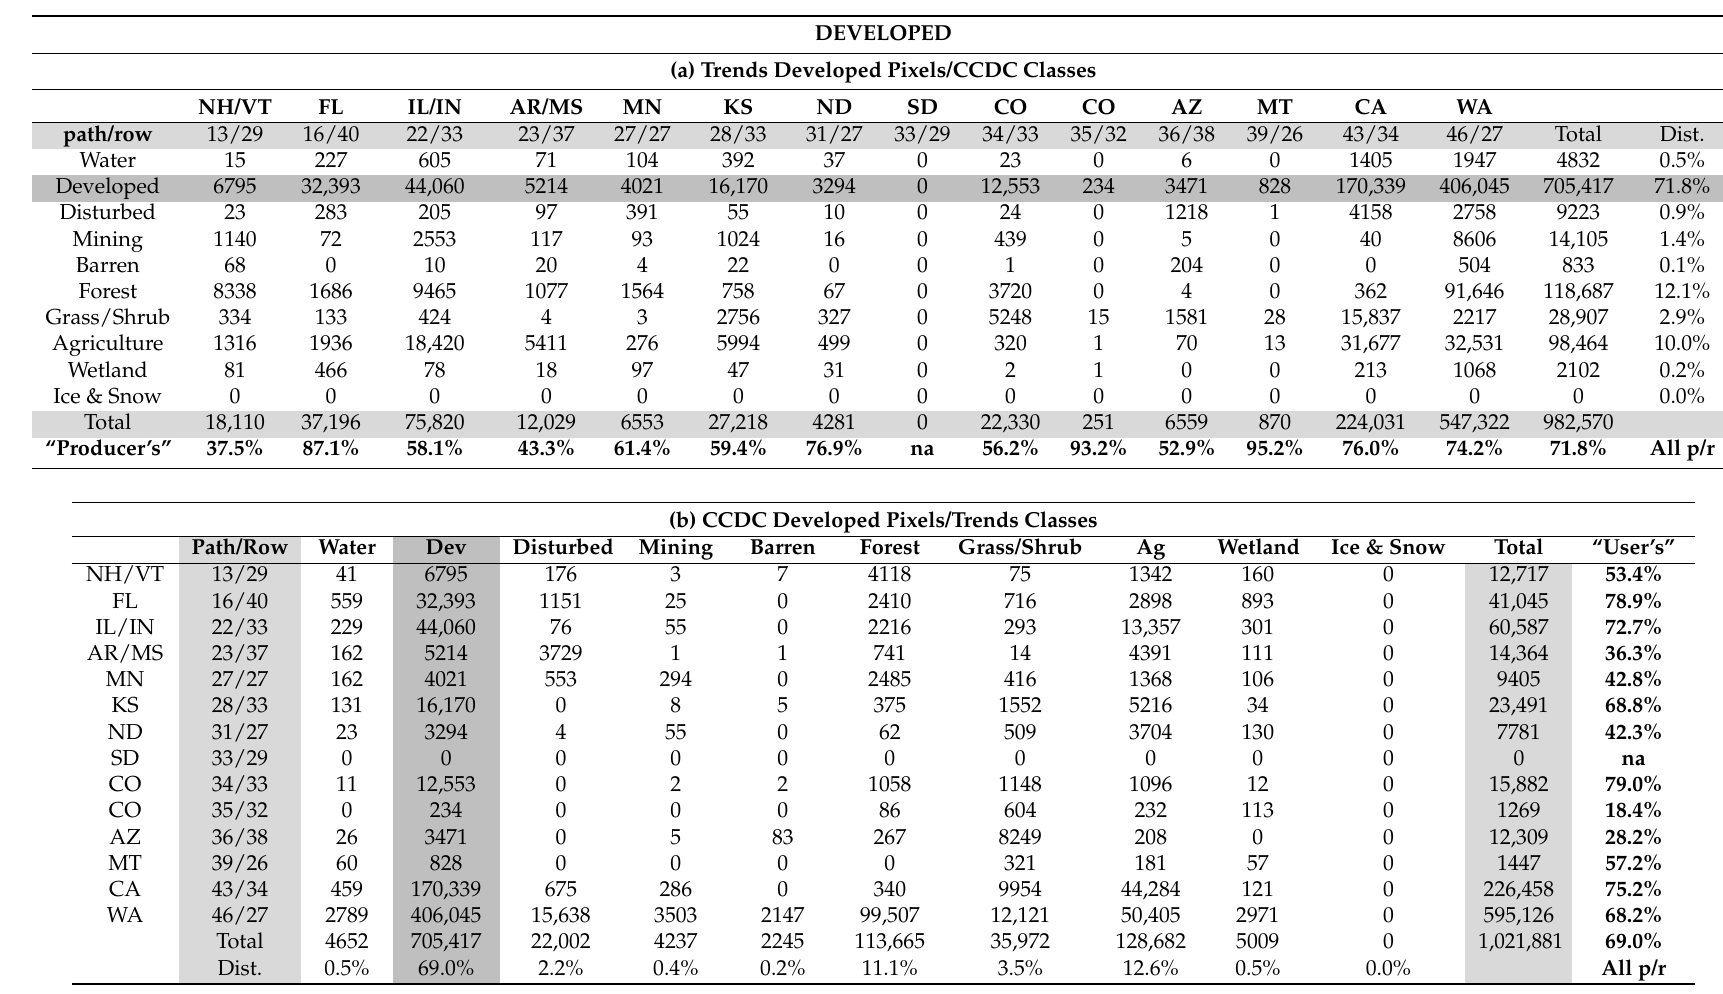
Table 8. (a) LC Trends Developed pixels distributed across CCDC classes for each path/row location and (b) CCDC Developed pixels distributed across LC Trends classes for each path/row. AR = Arkansas; AZ = Arizona; CA = California; CO = Colorado; FL = Florida; IL = Illinois; IN = Indiana; KS = Kansas; MN =